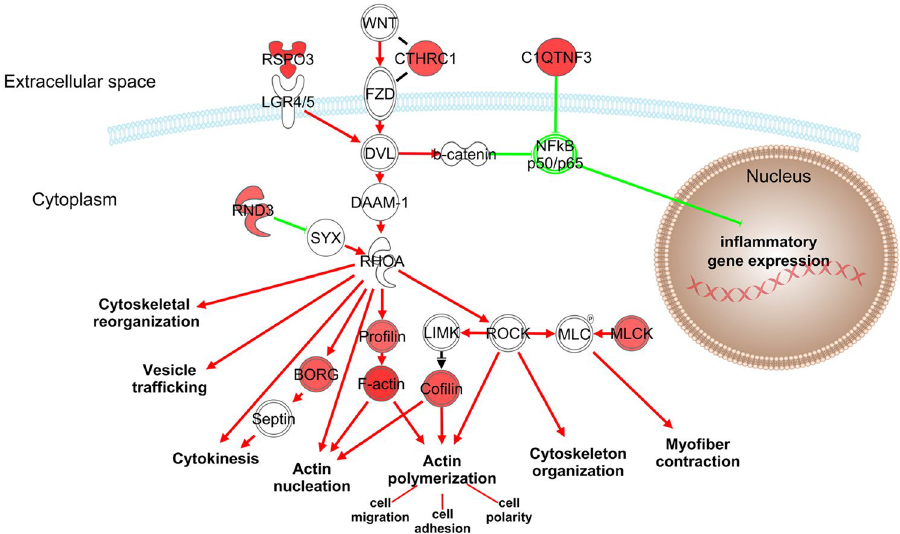
Figure 4. Summary of the regulatory events triggered by the S . aureus infection. Red and green colors symbolize activation or repression, respectively. BORG: binder of Rho GTPases (here: the DEG CDC42EP3); C1QTNF3, C1q and tumor necrosis factor related protein 3; CTHRC1, collagen triple helix repeat containing 1; DAAM-1, disheveled associated activator of morphogenesis 1; DVL, disheveled; FZD, frizzled receptor; LGR4/5, leucine-rich repeat-containing G-protein coupled receptor 4/5; LIMK, Lim kinase; MLC: myosin light chain; MLCK, myosin light chain kinase; RHOA, ras homolog family member A; RND3, Rho family GTPase 3; ROCK, Rho kinase; RSPO3, r-spondin 3; SYX, pleckstrin homology and RhoGEF domain containing